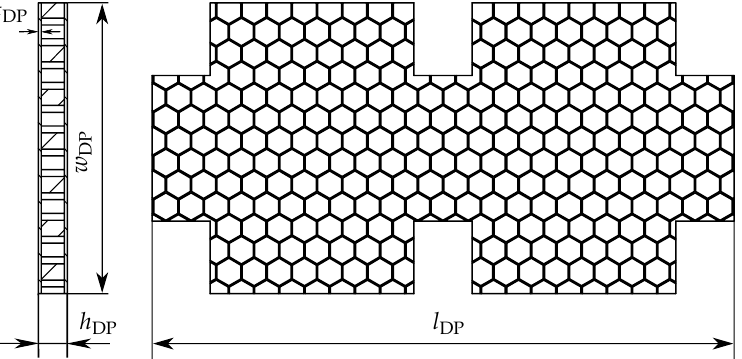
Figure 3. Design and geometry of honeycomb damping plate with length l DP , width w DP , and core height h DP . Thickness t DP is equal for top and bottom face sheet.